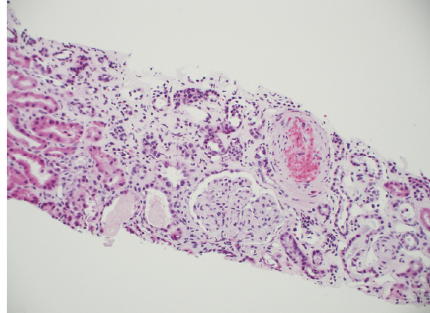
Figure 1: Schistocytes and thrombocytopenia on peripheral blood smear of Case A.